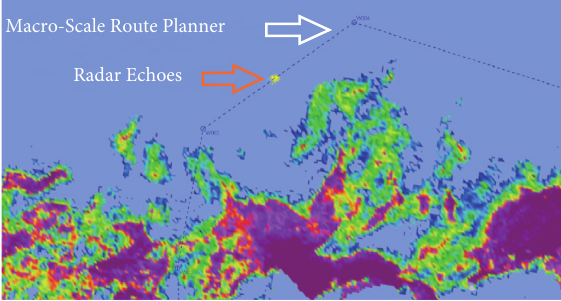
Figure 12: Overview of macroscale route planner.